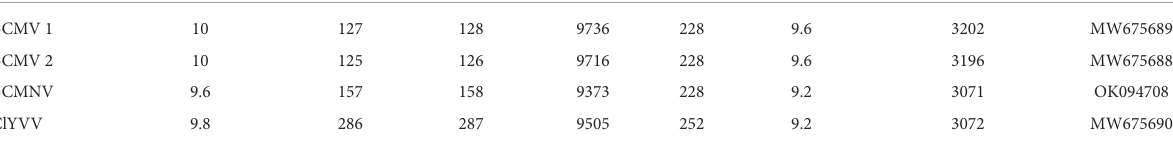
TABLE 4 The genome size, organization, and accession numbers of viruses identified from common bean leaf samples from next-generation